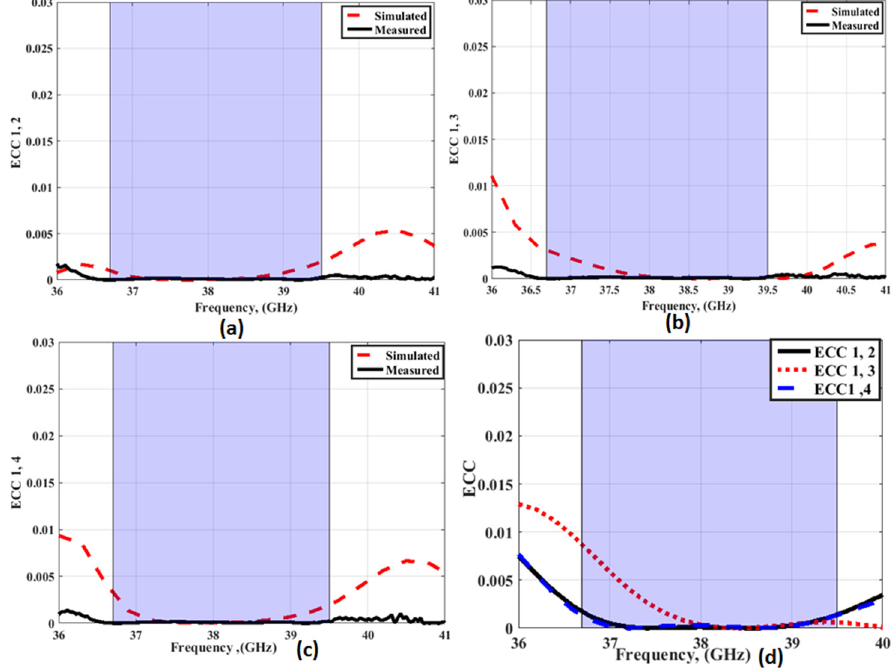
Figure 27. The ECC outcomes of the MIMO antenna with FSS at port 1 ( a ) ECC1, 2 ( b ) ECC 1, 3 ( c ) ECC 1, 4 ( d ) From radiation patterns.